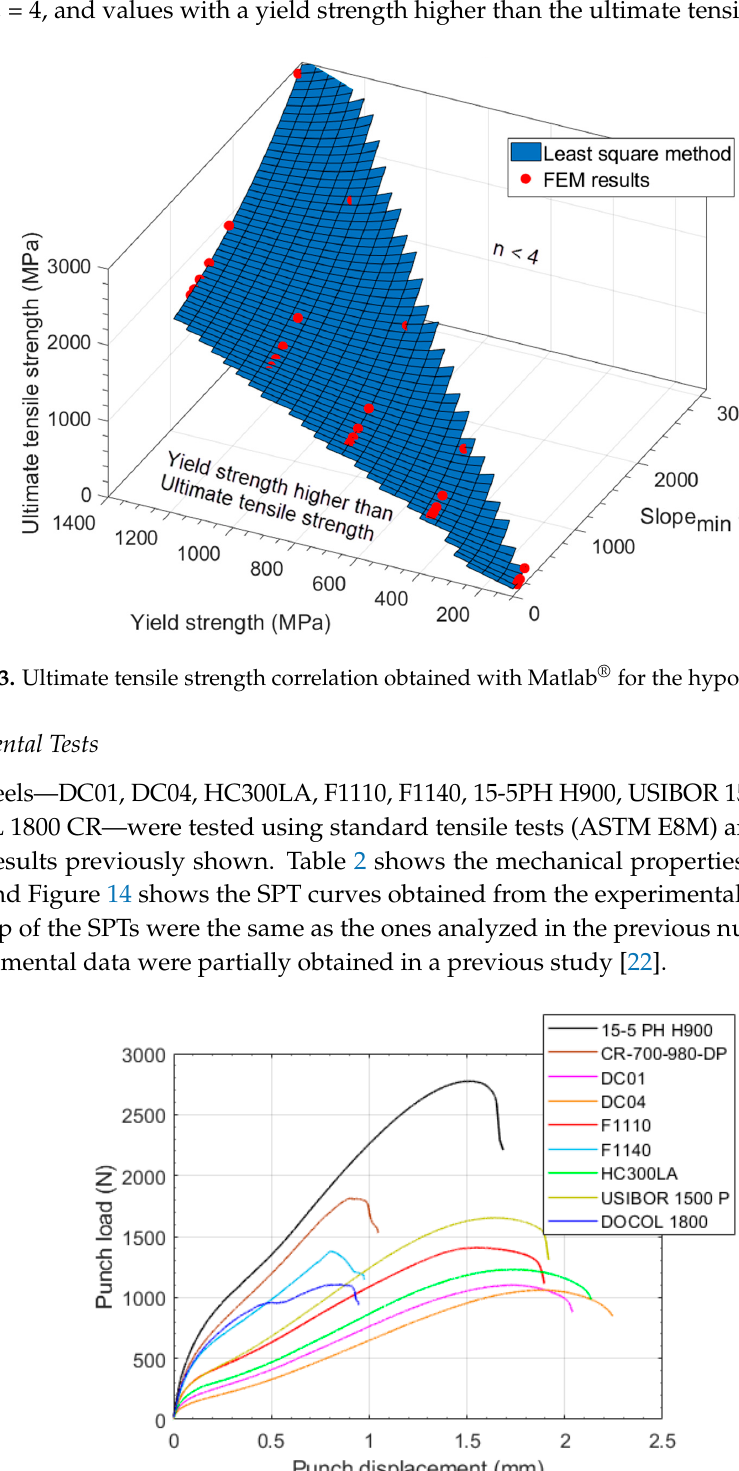
Figure 14. SPT curves of the experimental tests.